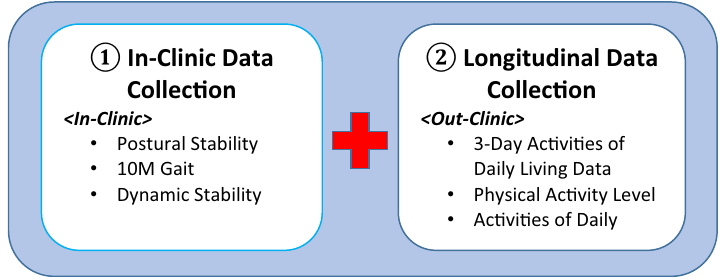
Figure 4. Study Design Layout for the 1. In-clinic Data collection, 2. Longitudinal Data